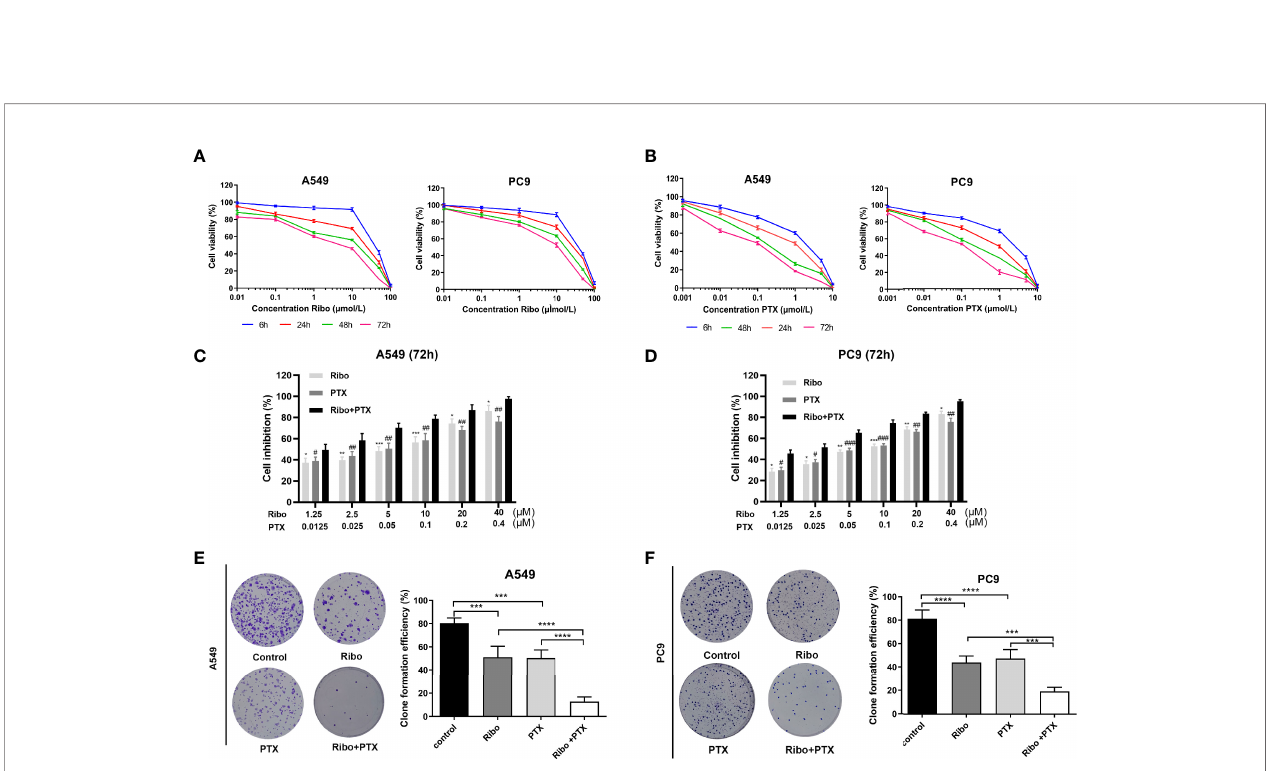
FIGURE 2 | Ribociclib plus pemetrexed enhanced the cytotoxicity in vitro. (A, B) A549 and PC9 cell lines were exposed to ribociclib and pemetrexed in combination or alone at different doses. (C, D) Cell lines were exposed to different combinations of pemetrexed and ribociclib dosages (*p < 0.05, **p < 0.01, and ***p < 0.001, ****p < 0.0001), ribociclib (Ribo) versus Ribo + pemetrexed (PTX) (#p < 0.05, ##p < 0.01, and ###p < 0.001), and PTX versus Ribo + PTX). (E, F) Representative images and quanti fi cation of colony formation assay. Data are presented as mean ± SD of triplicate experiments (*p < 0.05, **p < 0.01, ***p < 0.001 as ***p < 0.001, ****p < 0.0001). SD: standard